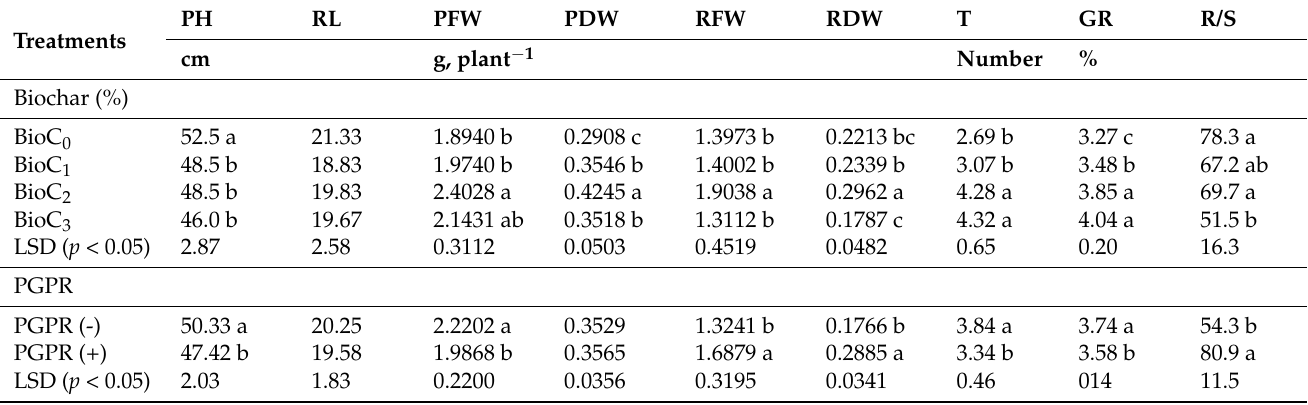
Table 8. Averages of the effects of Biochar and PGPR applications on development criteria and Duncan multiple comparison test